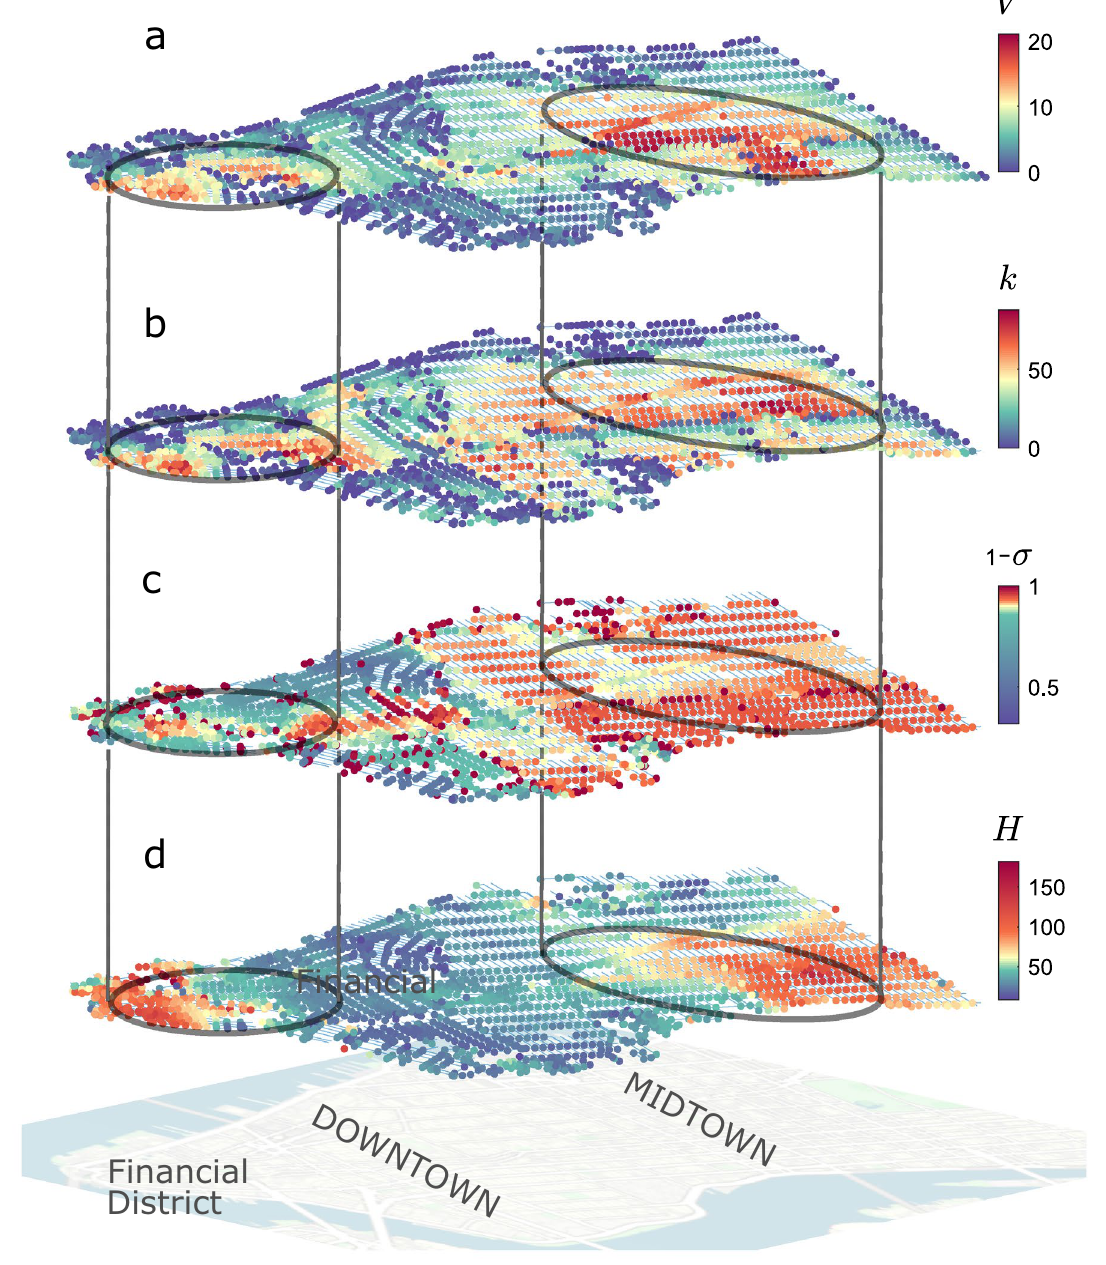
Figure 4. Street network of Midtown and Downtown Manhattan. Node color is associated to node vulnerability ( V ), and to its key indicators: street reachability ( k ), inhomogeneity in street orientation ( σ ), and average height of buildings in the node neighborhood ( H